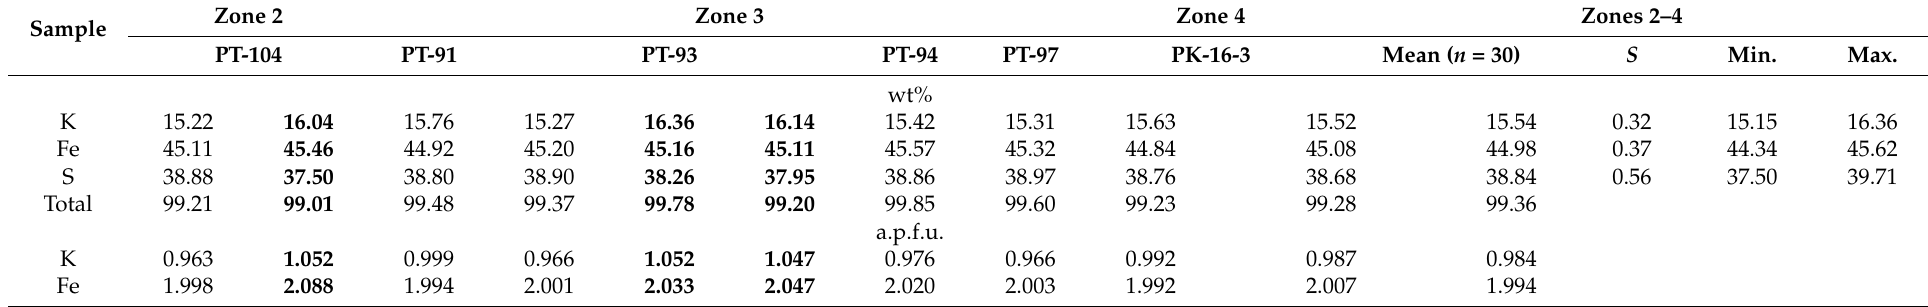
Table 9. Representative analyses and average compositions of rasvumite (KFe 2 S 3 ) from marbles of the Kochumdek contact aureole (SEM-EDS and EPMA